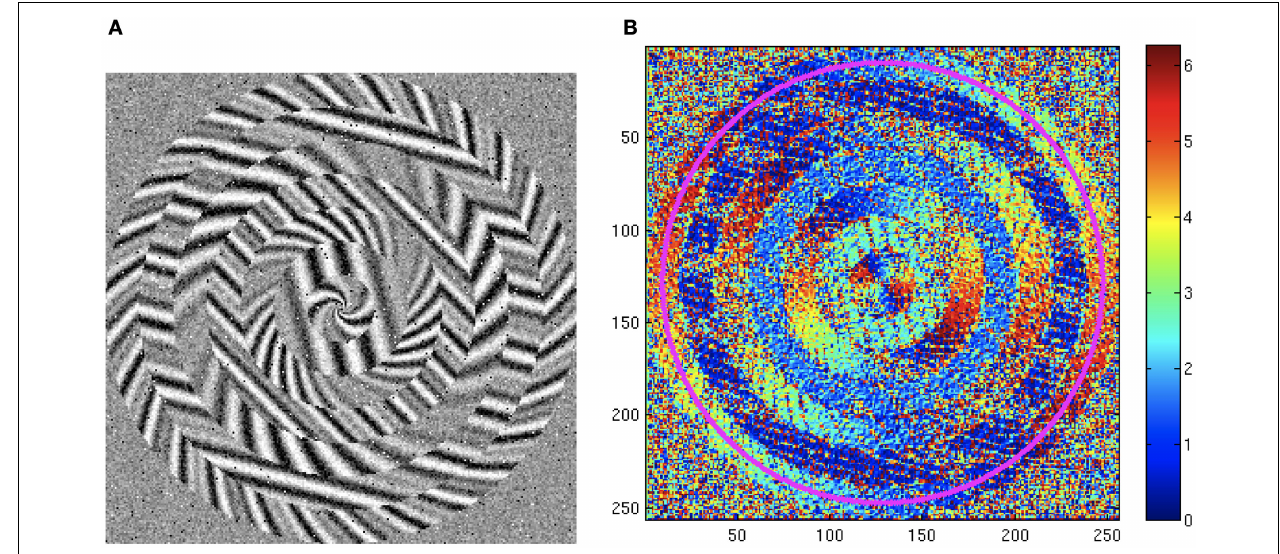
FIGURE 10 | Orientation experiment with a complex pattern (Felsberg et al., 2006) . (A) Example pattern with noise. (B) Raw orientation estimates computed with the Scharr filter (Scharr et al., 1997). The subsequent evaluation is made along the magenta circle.